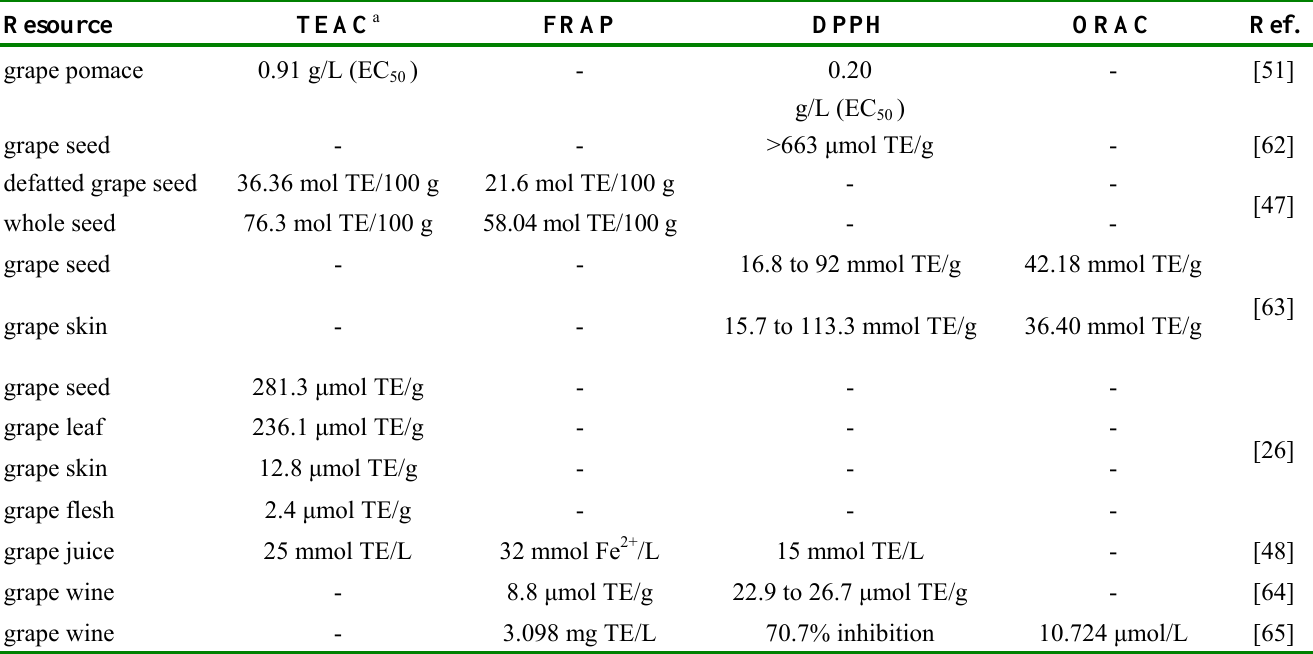
Table 2. The antioxidant capacities of the extracts from different parts of grape and its